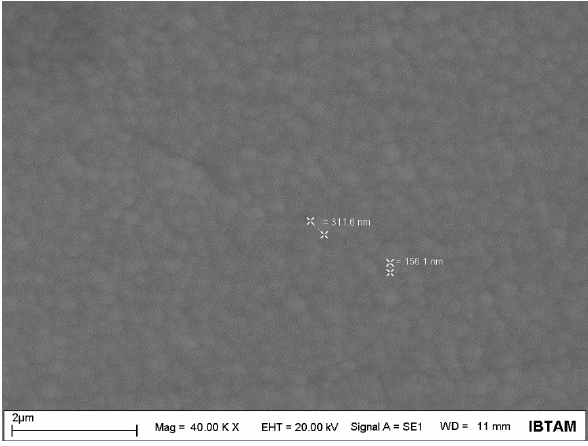
Figure 3: SEM image of the surface of the C3 coating